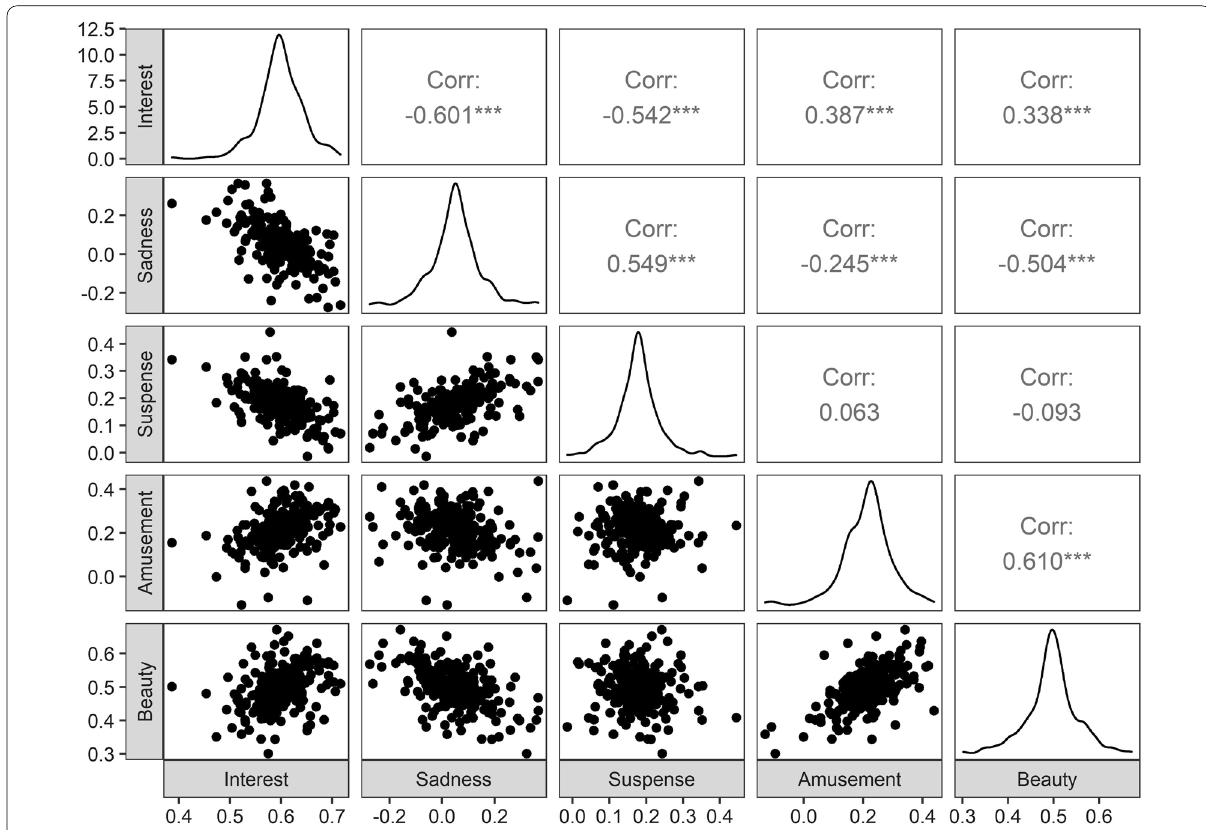
Fig. 3 Plot of the correlations between the slopes for the associations of the components and liking. Note Below the diagonal, scatterplots of the individual slopes are displayed. The diagonal represents density plots of the distributions of the slopes. Pearson correlation coefficients are given above the diagonal. *** indicates p < .001. Bonferroni correction for multiple comparisons was